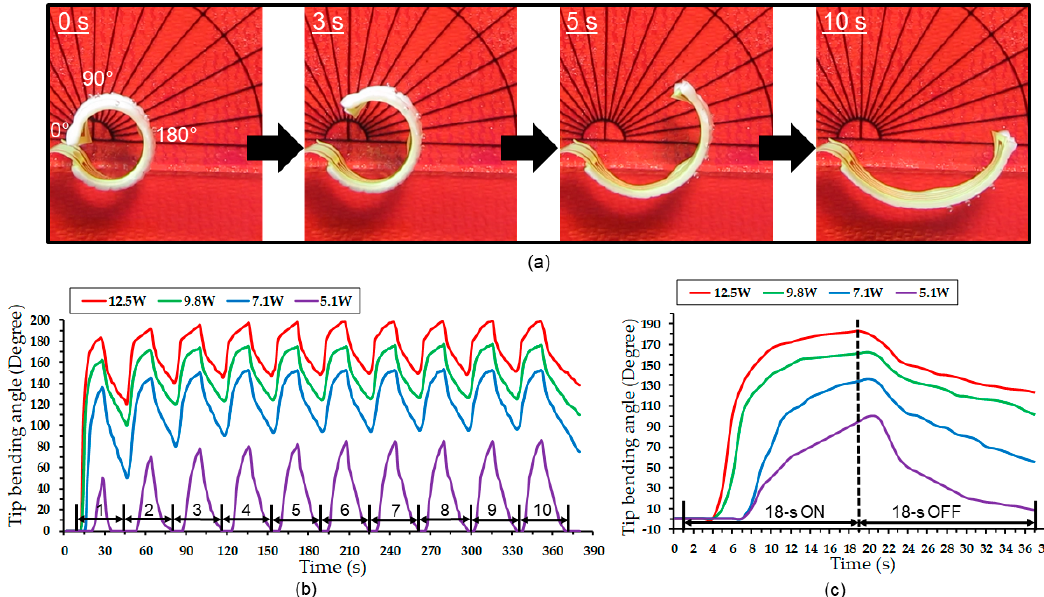
Figure 9. Temporal bending response of the device: ( a ) Optical images of transitional shapes of the activated device (placed over a protractor) showing the maximum bending angle of >170 ° at 10 s of powering (at 12.5 W); iterative cyclic powering (18 s on and 18 s off) showing ( b ) the results of ten powering cycles with varying input powers and ( c ) a close-up of single cycle.